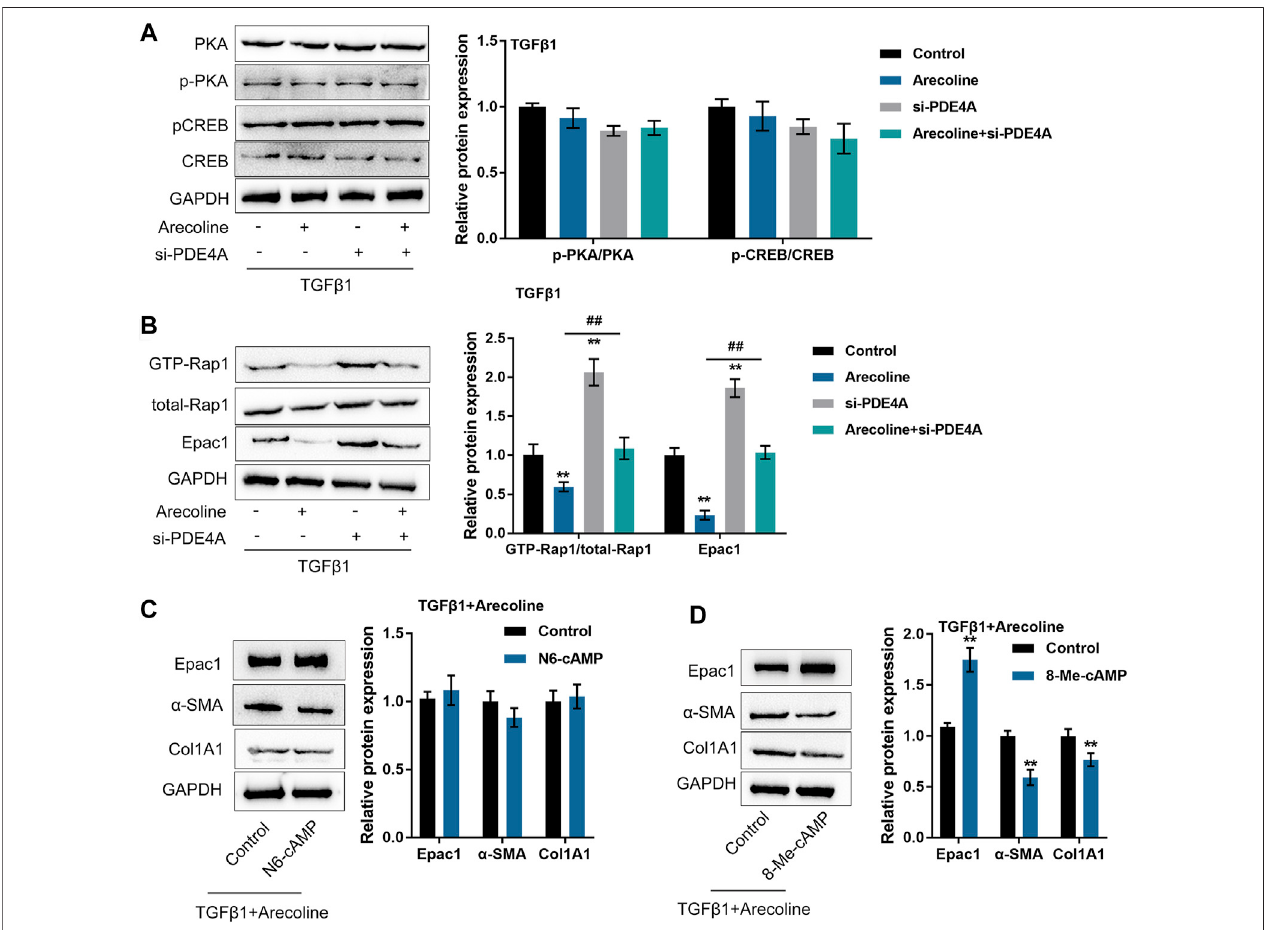
FIGURE 5 | Arecoline affects the effects of PDE4A on the cAMP pathway upon TGF- β 1 stimulation. BMFs were transfected with si-PDE4A in the presence or absence of 50 µg/ml arecoline treatment upon 5 ng/ml TGF- β 1 stimulation, and then examined for (A) the protein levels of PKA, p-PKA, CREB, and p-CREB by Immunoblotting, n (cid:1) 3. (B) the protein levels of GTP-Rap1, total Rap1, and Epac1 by Immunoblotting, n (cid:1) 3. ** p < 0.01, compared to the control group; ## p < 0.01, compared to arecoline group. ANOVA followed by Tukey post-hoc test. (C) BMFs were co-treated with arecoline and TGF- β 1 in the presence or absence of PKA- selective cAMP analog N6-cAMP, and then examined for the protein levels of Epac1, α -SMA and Col1A1 by Immunoblotting, n (cid:1) 3. (D) BMFs were co-treated with arecoline and TGF- β 1 in the presence or absence of Epac1-selective cAMP analog 8-Me-cAMP, and then examined for the protein levels of Epac1, α -SMA and Col1A1 by Immunoblotting, n (cid:1) 3. ** p < 0.01, compared with the control group, student t